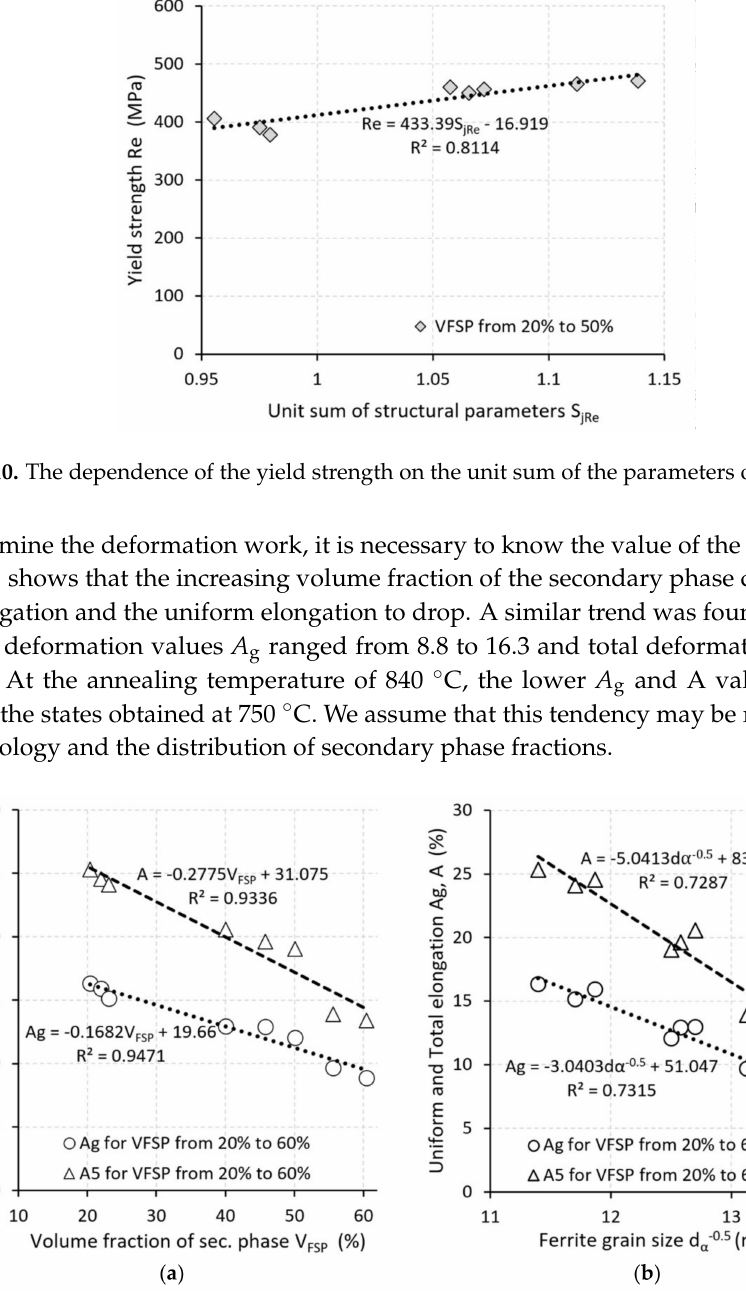
Figure 11. The dependence of the uniform and total elongation on ( a ) the volume fraction of the secondary phase; ( b ) the ferritic grain